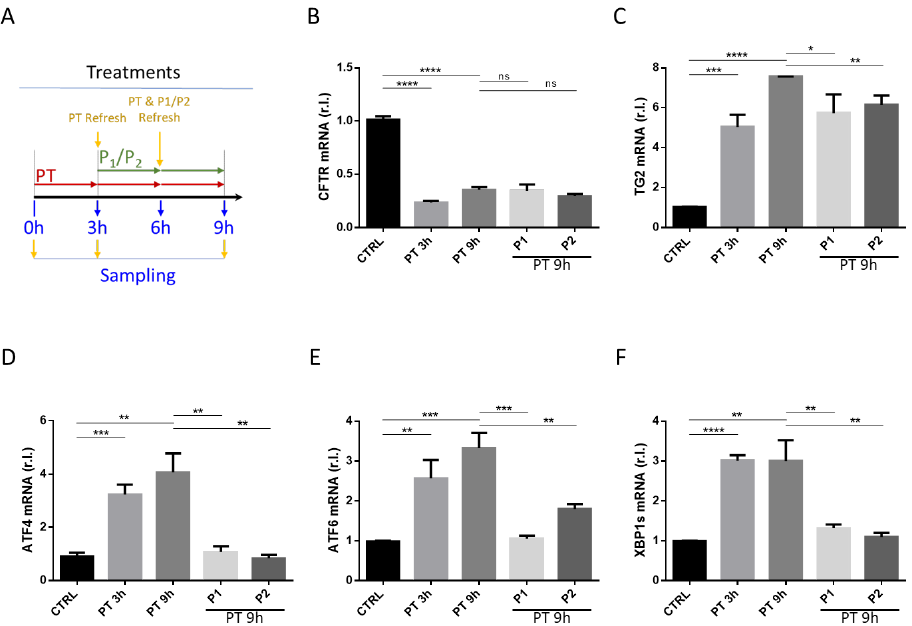
Figure 5. Impact of probiotics on peptide (PT)-mediated ER Stress induction in vitro. Caco-2 cells were untreated (CTRL) or treated with PT-gliadin for 3 (PT 3 h) or 9 (PT 9 h) hours in the presence or absence of P1 or P2 as schematically reported in panel ( A ). CFTR ( B ), TG2 ( C ), ATF4 ( D ), ATF6 ( E ), and XBP1s ( F ) expression levels were evaluated by qRT-PCR. Mean ± SD of triplicate sample; **** p < 0.0001; *** p < 0.001; ** p < 0.01; * p < 0.05; ns = not significant.